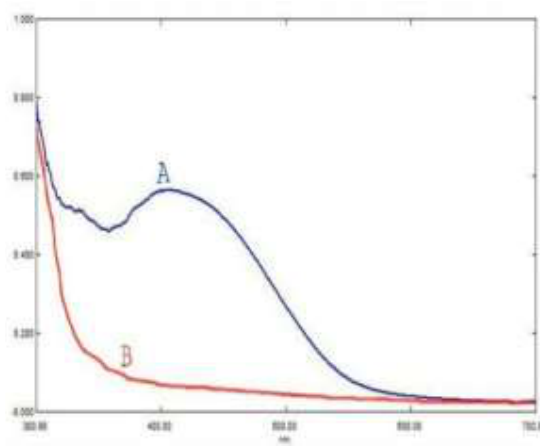
Figure 3. A: Absorption spectrum of azo dye formed when 20 µg.ml -1 of GEN